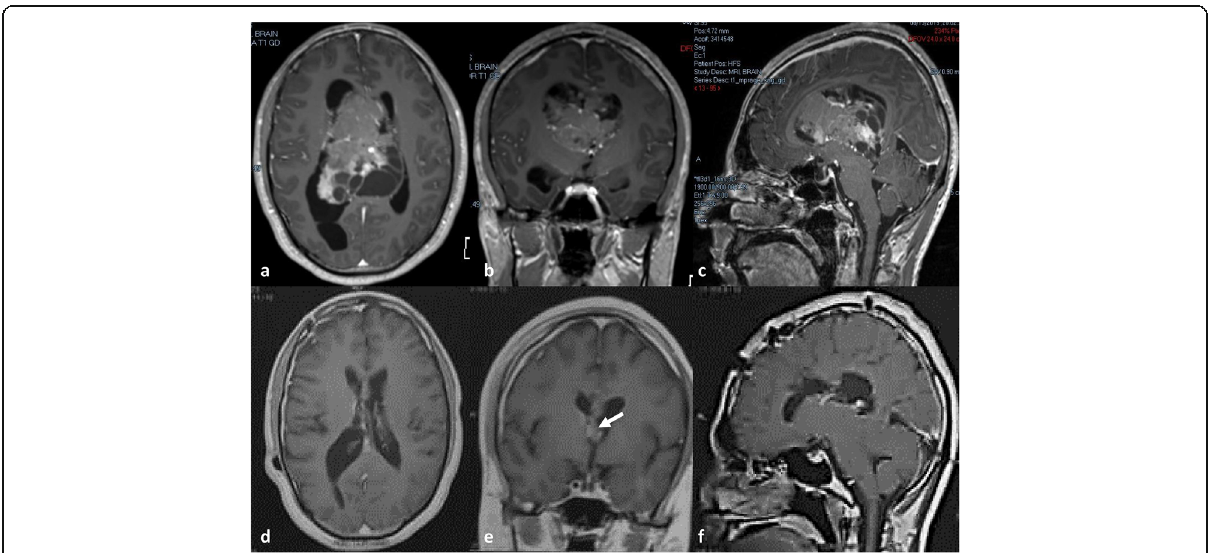
Fig. 1 A large intraventricular central neurocytoma in a 25-year-old male patient, who presented with headaches and blurring of vision. a – c The preoperative axial, coronal, and sagittal contrast-enhanced brain MRI study. d – f The postoperative axial, coronal, and sagittal contrast-enhanced brain MRI study. Near-total excision of the tumor was achieved following a right frontal trans-cortical approach through the right middle frontal gyrus, leaving a small septal residue (white